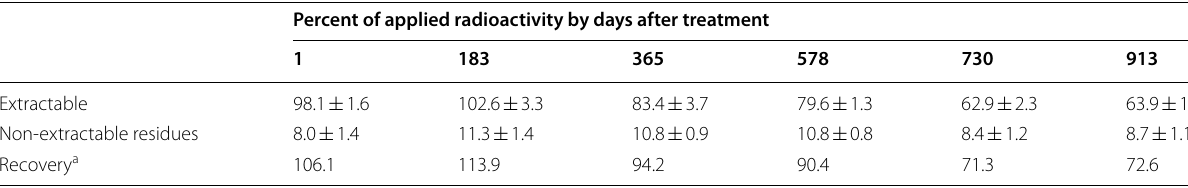
Table 1 Distribution of radioactivity in 0–5 cm top soil layer (% aR) after 1 M NaOH